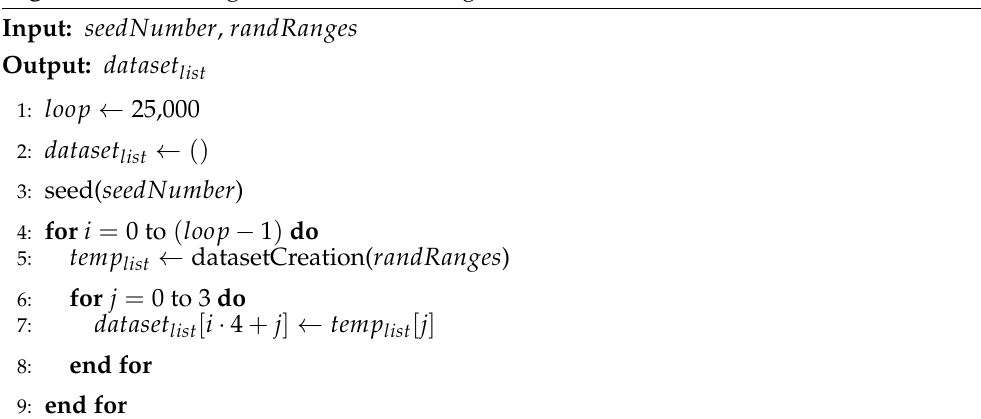
Algorithm 1 Creating a dataset for training the MTL model.